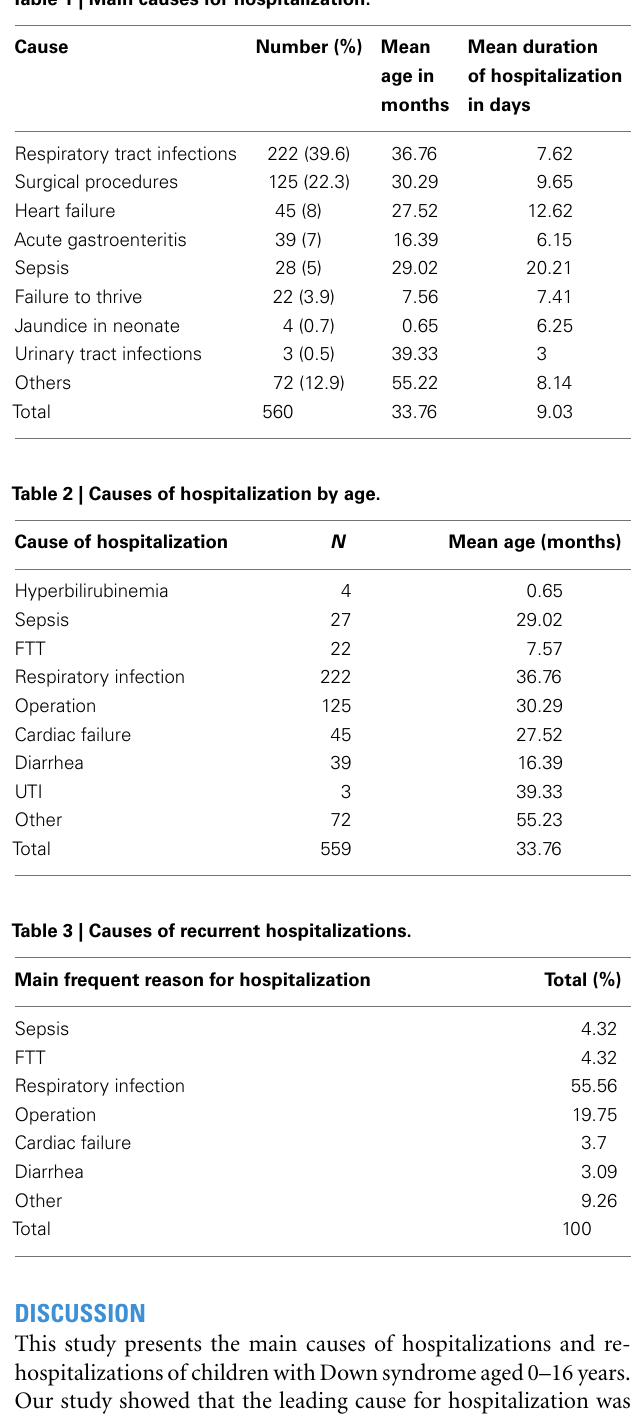
Table 1 | Main causes for hospitalization.